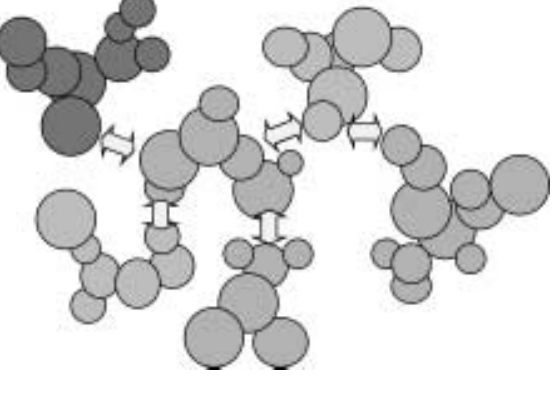
Fig. 1 Interaction of aggregates (schematically).